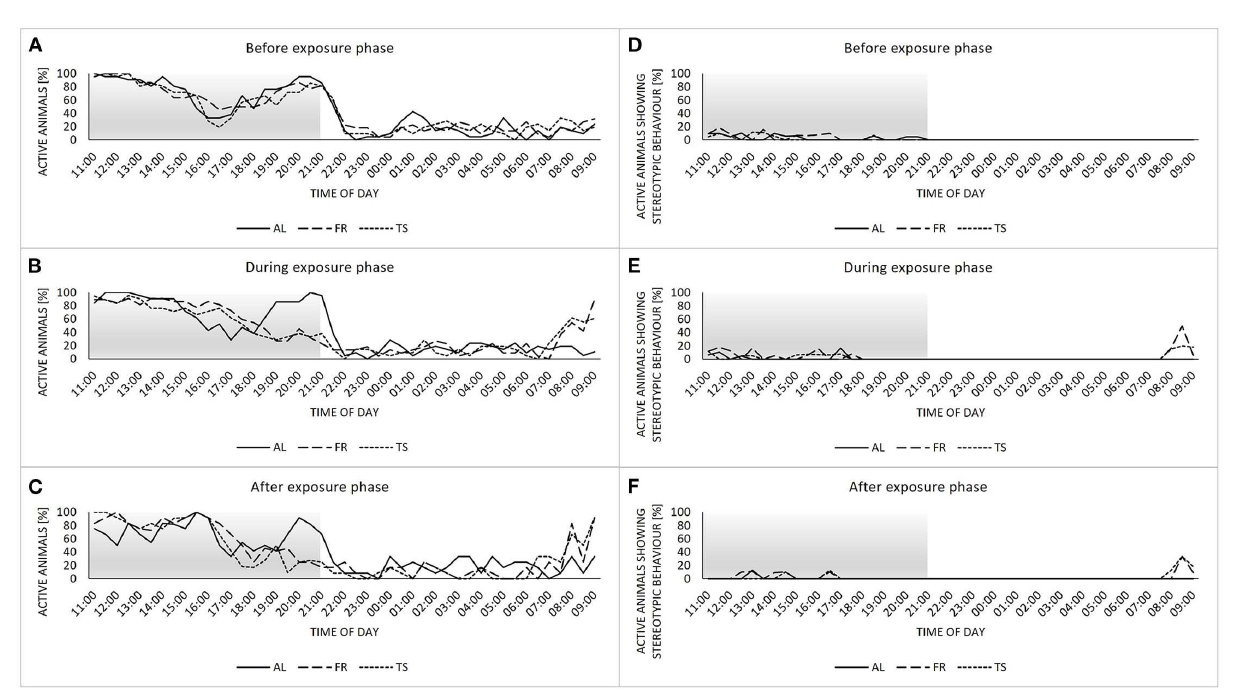
FIGURE4 Home cage behavior. (A–C) percentage of active individuals per sample point divided by group (AL, ad libitum fed mice; FR, food restricted mice; TS, touchscreen trained mice) for the recording times before (A) , during (B) and after (C) the exposure phase. (D–F) percentage of active animals showing stereotypic behavior divided by group for the recording times before (D) , during (E) and after (F) the exposure phase. Sample sizes: n = 24/group for (A–E) and n = 12/group for (C, F) . Sample sizes can vary slightly between groups and sample points, due to technical issues with the camera system (for details see Supplementary material). Gray area highlights the dark